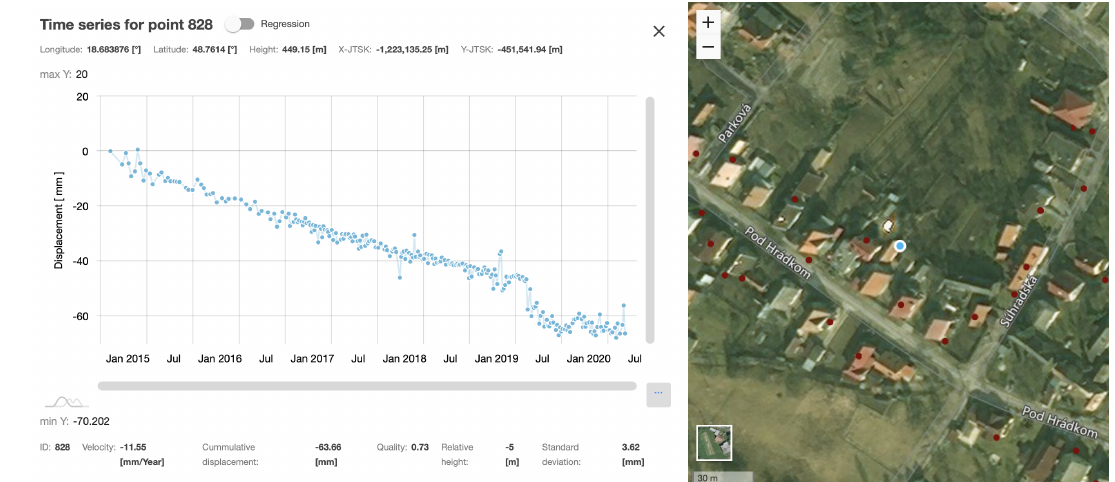
Figure 11. Example of remotIO PS point with triggered ’Displacement